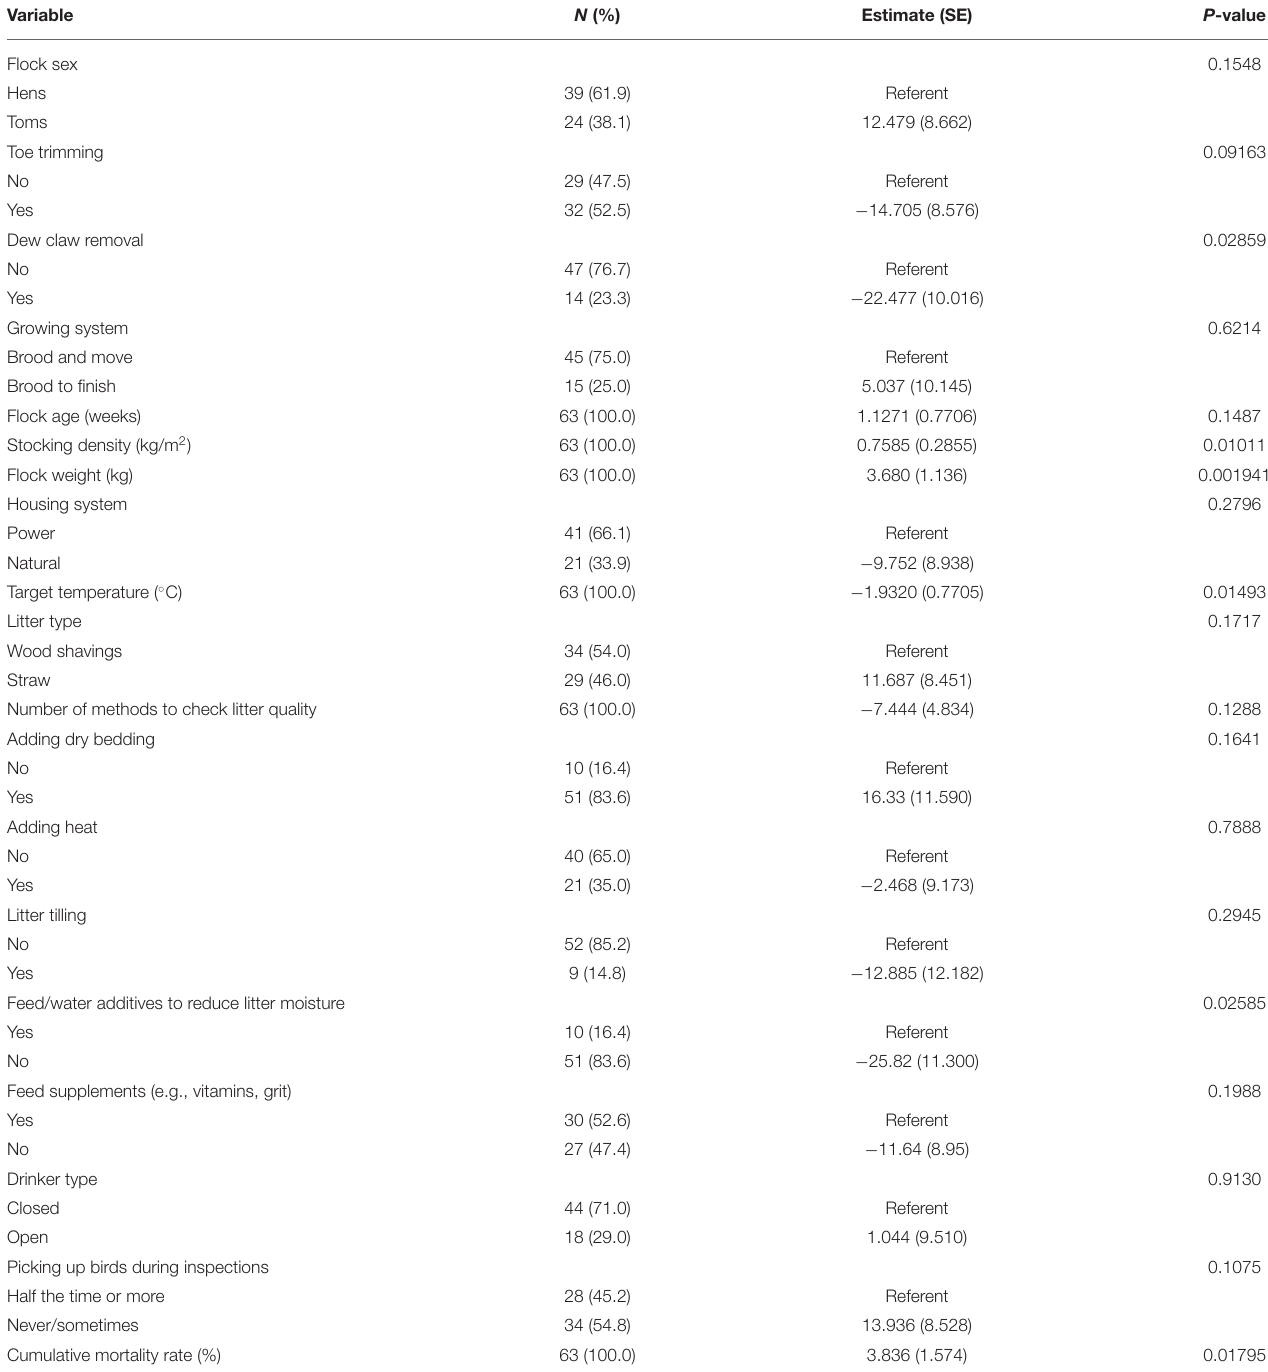
TABLE 4 | Explanatory variables ( p ≤ 0.25 or biologically relevant) associated with FDP in turkeys at the univariate analysis level.